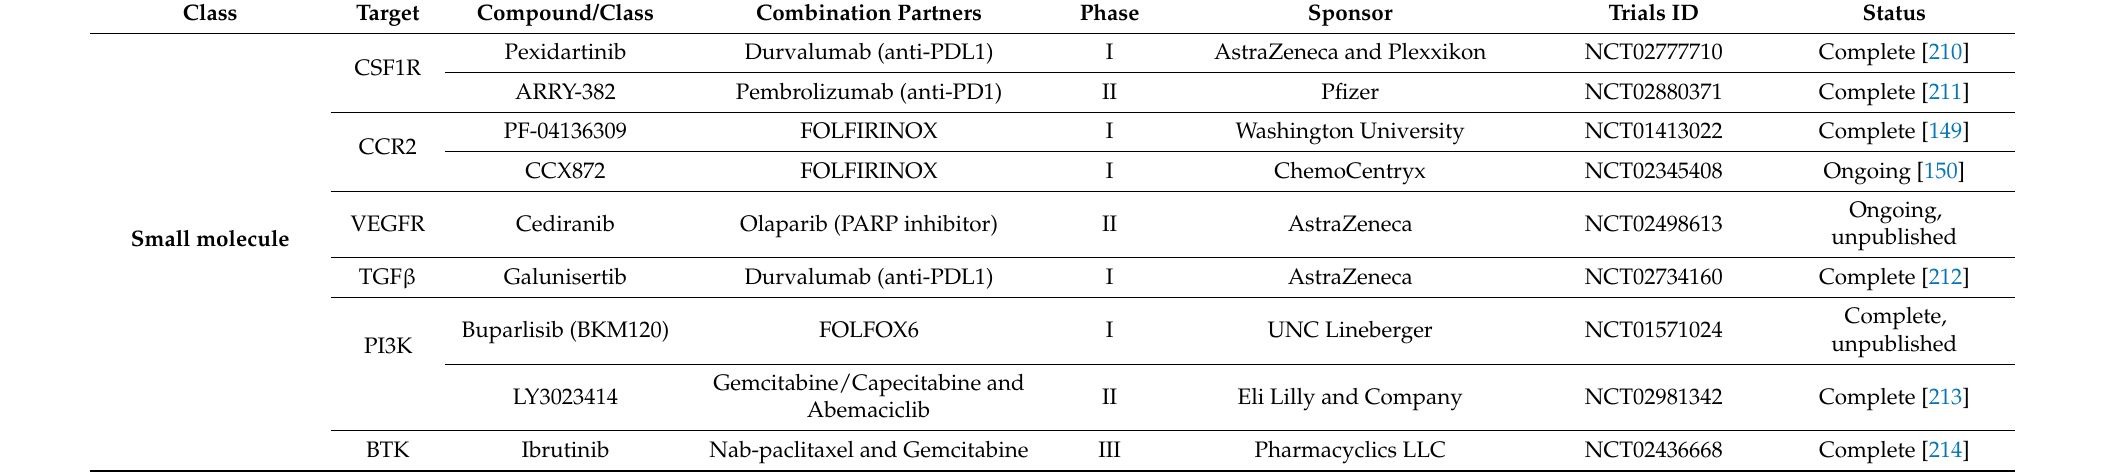
Table 2. Summary of selected clinical trials targeting TAMs in pancreatic